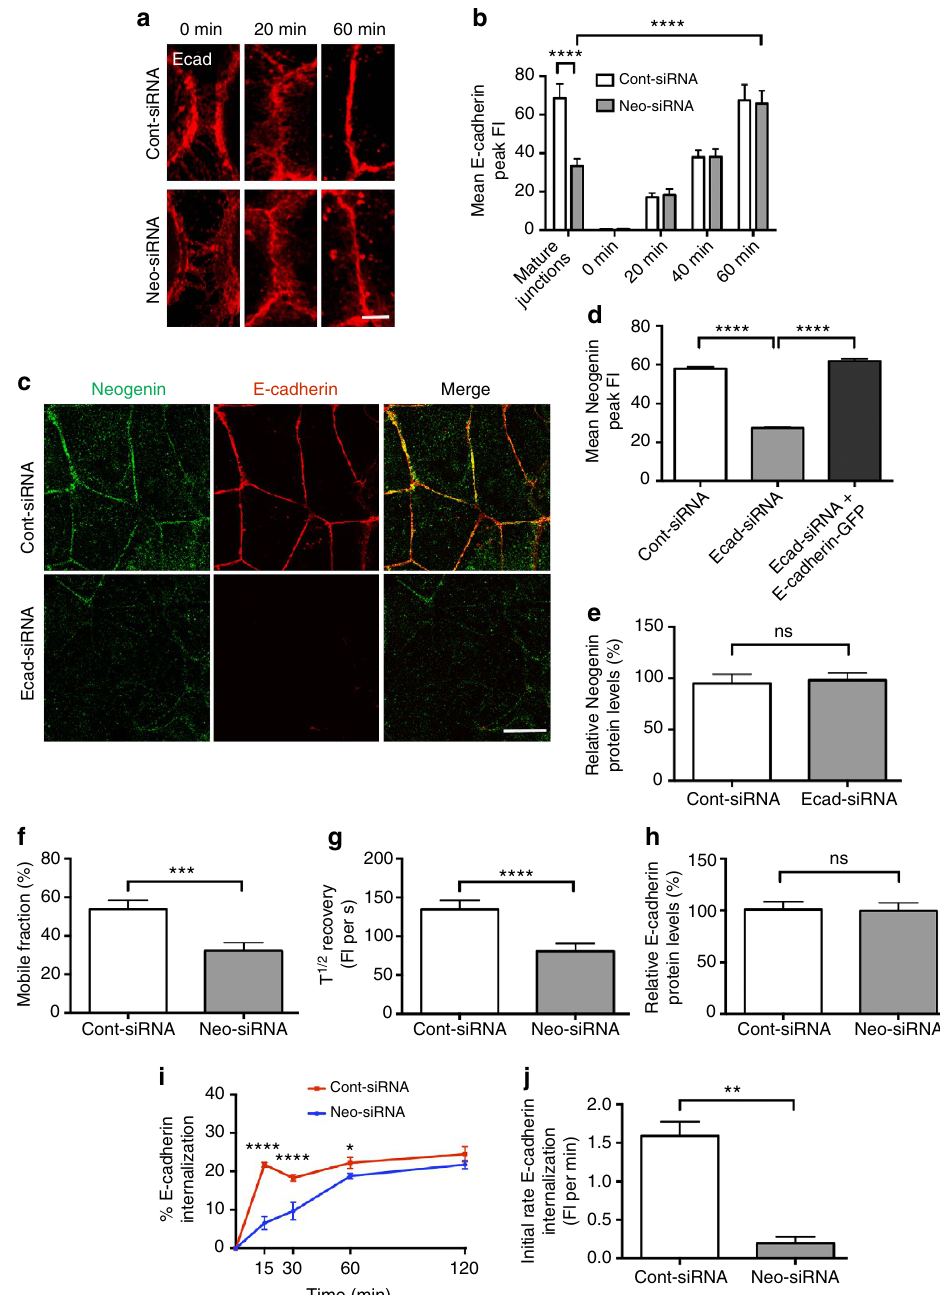
Figure 2 | Neogenin controls cadherin recycling and AJ stability but not junction assembly. ( a , b ) Calcium depletion assays demonstrated that Neogenin was not required for junction assembly. ( a ) Re-establishment of AJs (Ecad, red) 0–60min after calcium replacement. ( b ) Line-scan analysis: mean Ecad peak fluorescence intensity (FI) 0–60min after calcium replacement ( n ¼ 150 junctions, **** P o 0.0001, two-way analysis of variance (ANOVA), Bonferroni’s post hoc test). ( c ) Neogenin (green) was lost from the AJ after transfection of Ecad-siRNA (Ecad, red). ( d ) Line-scan analysis shows that coexpression of Ecad-GFP with Ecad-siRNA rescued Neogenin levels at the AJ: mean Neogenin peak FI at the AJ ( n ¼ 150 junctions, mean ± s.e.m., **** P o 0.0001, Student’s t -test). ( e ) Densitometry of immunoblots: total cellular Neogenin levels were equivalent in the presence and absence of Ecad ( n ¼ 3, mean ± s.e.m., P 4 0.05, Student’s t -test). ( f , g ) FRAP analysis revealed that loss of Neogenin reduced the mobile pool of Ecad-GFP ( f ) and the time taken to reach 50% maximum fluorescence recovery (T 1/2 recovery) after bleaching ( g ) ( n 4 30, mean ± s.e.m., *** P o 0.001, **** P o 0.0001, Student’s t -test). ( h ) Densitometry of immunoblots: total cellular Ecad levels were equivalent in the presence and absence of Neogenin ( n ¼ 3, mean ± s.e.m., P 4 0.05, Student’s t -test). ( i ) Surface biotinylated-Ecad internalization was impeded in Neo-siRNA cells after raising the temperature from 0 to 37 (cid:2)